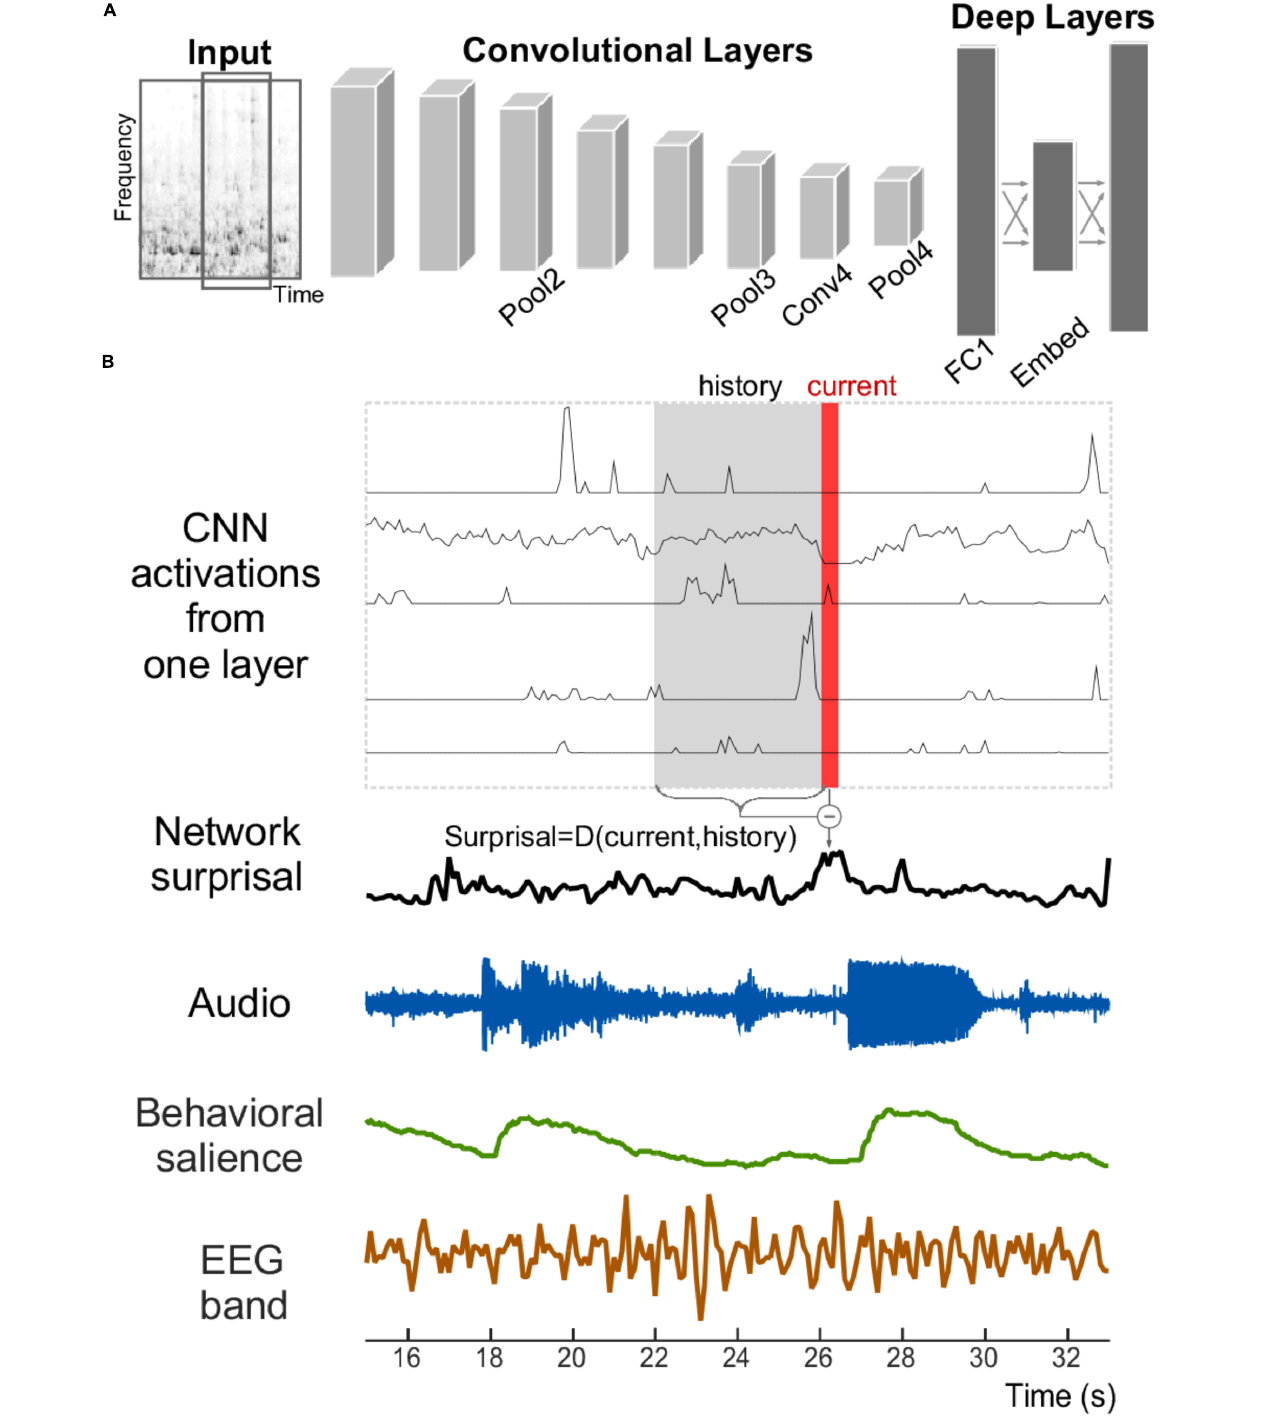
FIGURE 1 | Structure of the convolutional neural network and signals analyzed. (A) The convolutional neural network receives the time–frequency spectrogram of an audio signal as input. It is composed of convolutional and pooling layers in an alternating fashion, followed by fully connected layers. (B) An example section of an acoustic stimulus (labeled Audio); along with corresponding neural network activity from five example units within one layer of the CNN. A network surprisal measure is then computed as the Euclidian distance between the current activity of the network nodes at that layer (shown in red) against the activity in a previous window (shown in gray with label “History”). Measures of behavioral salience by human listeners (in green) and cortical activity recorded by EEG (in brown) are also analyzed.